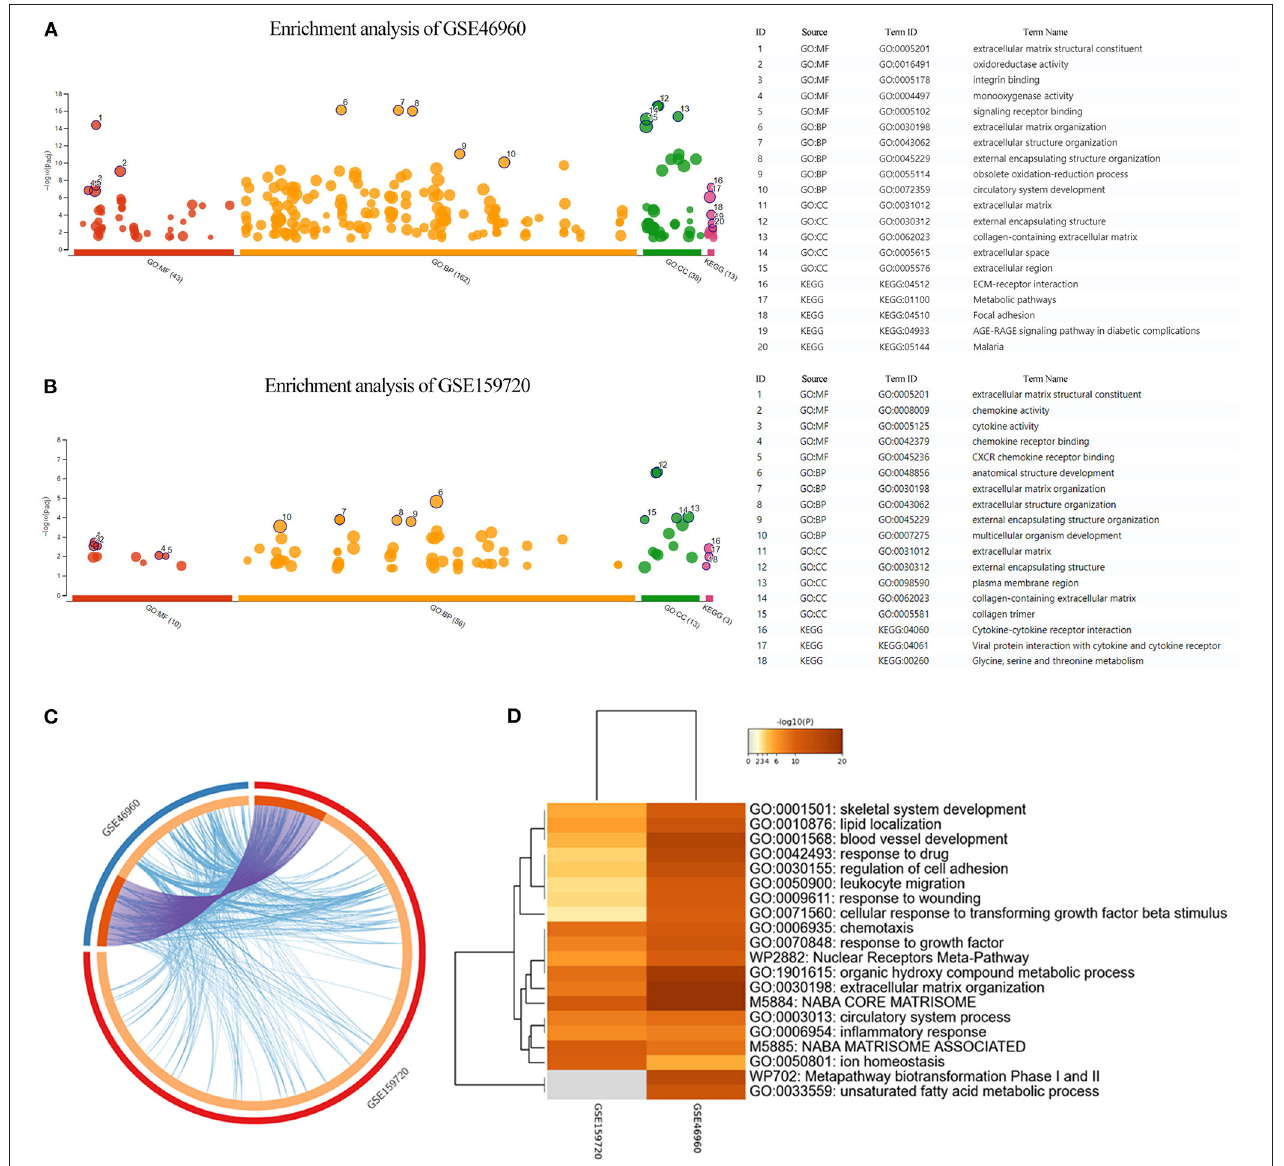
FIGURE 2 | Enrichment analysis of GEO data sets. (A,B) GO enrichment analysis and KEGG enrichment analysis of GSE46960 and GSE159720 demonstrated that the immune process plays an essential role in biliary atresia liver according to gene expression. (C) Overview of duplicate DEGs and shared ontology terms of GSE46960 and GSE159720. Purple lines linked the duplicated genes, and blue lines linked the different genes where they fall into the same ontology term. (D) Heat map of enriched terms across GSE46960 and GSE159720. Here, we visualized the top 20 clusters. GO, Gene Ontology; MF, molecular function; BP, biological process; CC, cellular component; KEGG, Kyoto Encyclopedia of Genes and